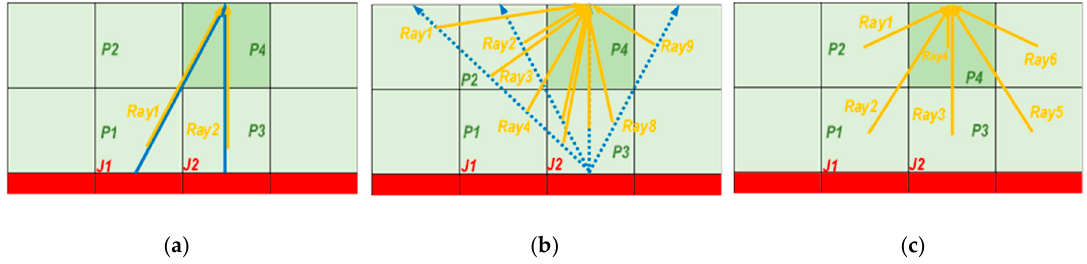
Figure 16. Strategies to count the number of yellow light rays: ( a ) Common yellow and blue rays; ( b ) yellow rays triggered by blue rays arriving directly from an elementary junction surface; ( c ) indirect yellow rays.